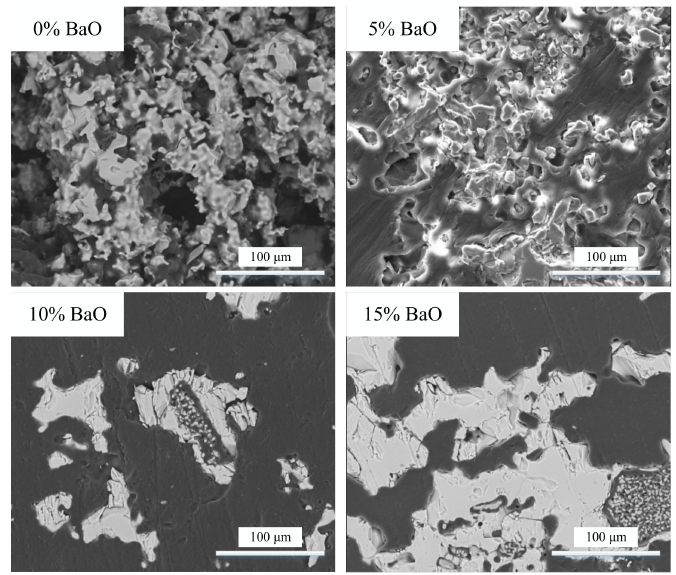
Figure 11. SEM images of C 2 S–C 3 P solid solution under 1000 × magnification.